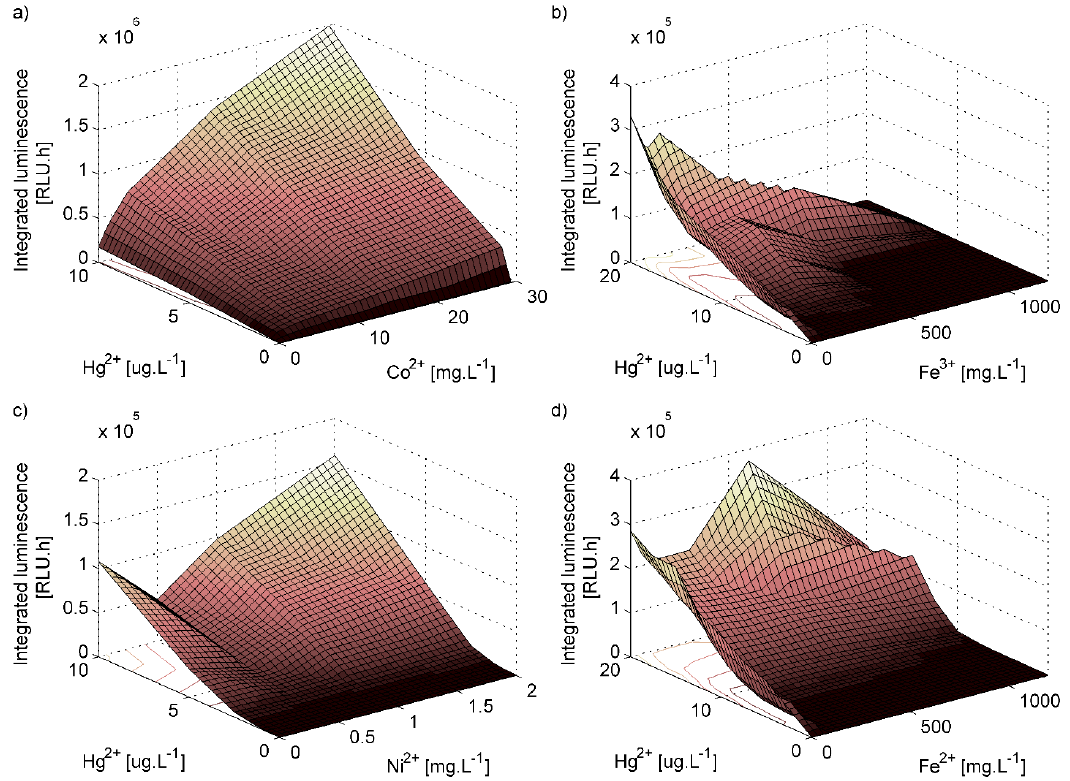
Figure 6. Dependence of integrated bioluminescence measured in water solutions on mercury concentrations (mercury was added in the form of mercury (II) chloride) under influence of added concentrations of chlorides of ( a ) cobalt (II), ( b ) iron (III), ( c ) nickel (II) and ( d ) iron (II).